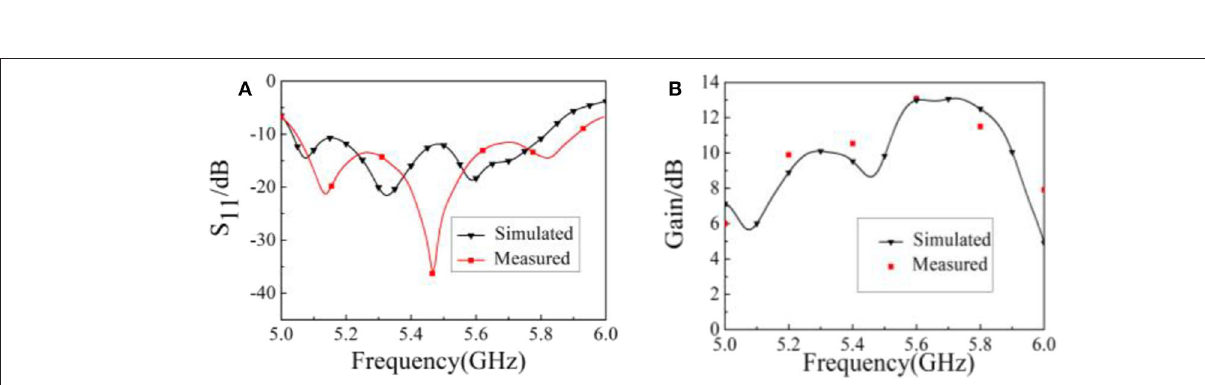
FIGURE 10 | Radiation patterns of the type I antenna at 5.62GHz. (A) E-plane and (B) H-plane.